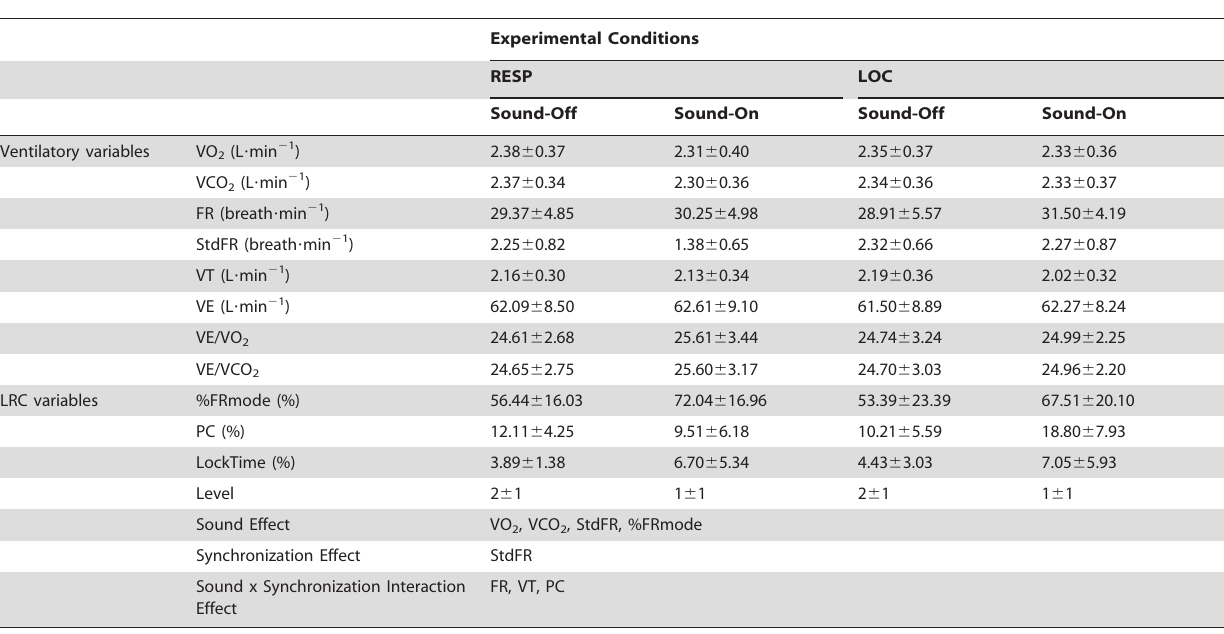
Table 1. Means 6 standard deviation of ventilatory and LRC variables (12